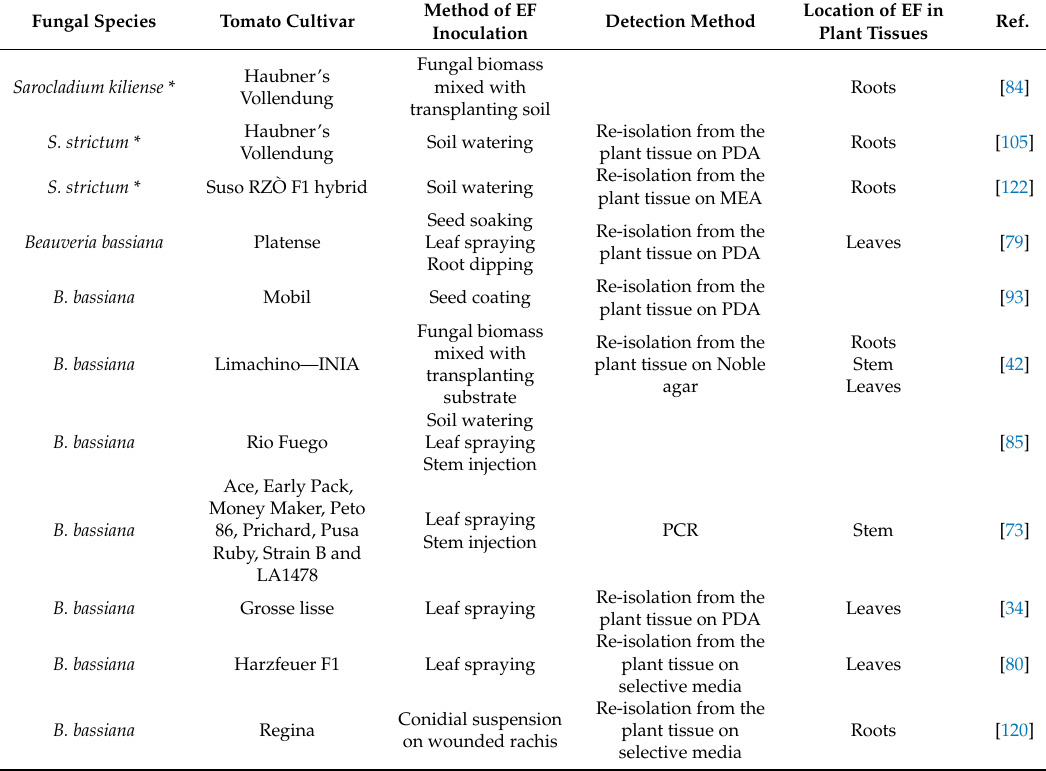
Methods of introduction and detection of fungal endophytes in tomato plant with relative